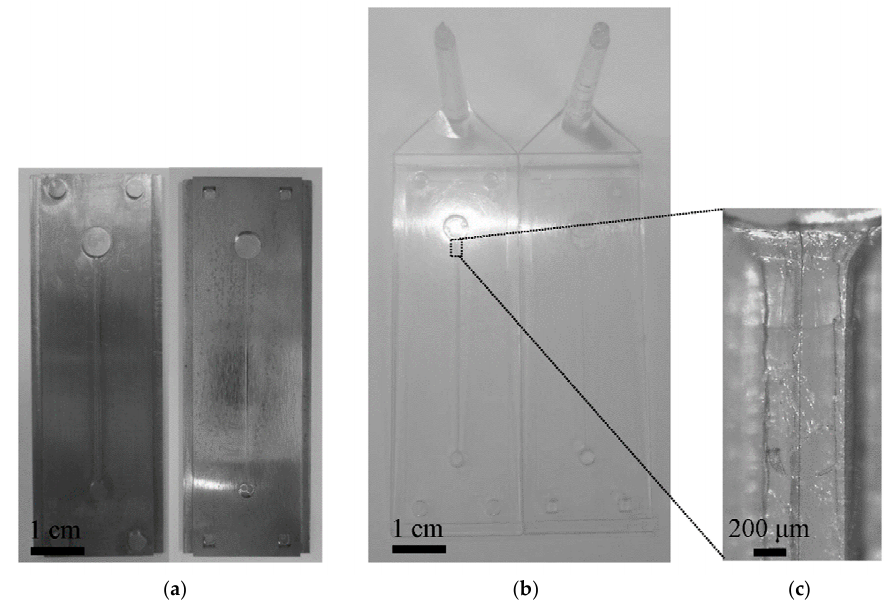
Figure 5. Photographs of mold inserts ( a ), injection molded substrates ( b ) and a micrograph of the microchannel ( c ). There is weldline along the center of the microchannel in the micrograph.